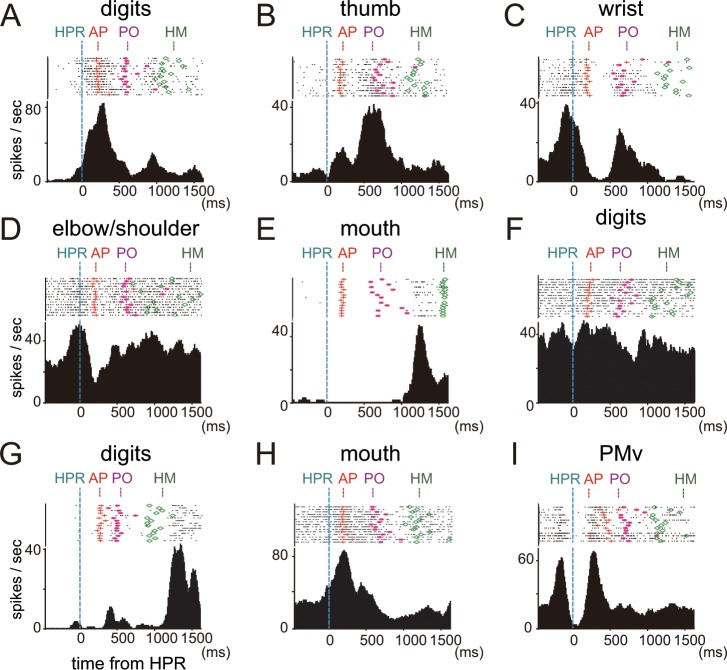
Single-unit recordings in M1 and PMv during the motor task.(A–E) Examples of neurons whose firing rates changed during the task. The timing of responses was consistent with the movements of the body part represented in the recording site. Raster plots and firing rate histograms show examples of neuronal firing during the precision grip task, aligned to the time of HPR (dashed blue lines), in each body representation—digits (A), thumb (B), wrist (C), elbow/shoulder (D), and mouth (E)—of the intracortical microstimulation (ICMS) map in the primary motor cortex (M1). The red crosses, pink asterisks, and green diamonds in the raster plot indicate the times of approaching the target (AP), pulling the target out (PO), and bringing the hand to the mouth (HM), respectively, in each trial. (F–H) Examples of neuronal responses that did not correspond to the body representation on the ICMS map; a neuron in the digit representation that showed no modulation during the task (F), and neurons in the digit and mouth representations showed peak activity in the periods around HM (G) and AP (H), respectively. The higher threshold (HT) neurons shown in (F–H) were located at recording sites with movement thresholds of at least 15μA. (I) A raster plot and firing rate histogram showing examples of neuronal firing during the precision grip task, aligned to the time of HPR, in the ventral premotor cortex (PMv).